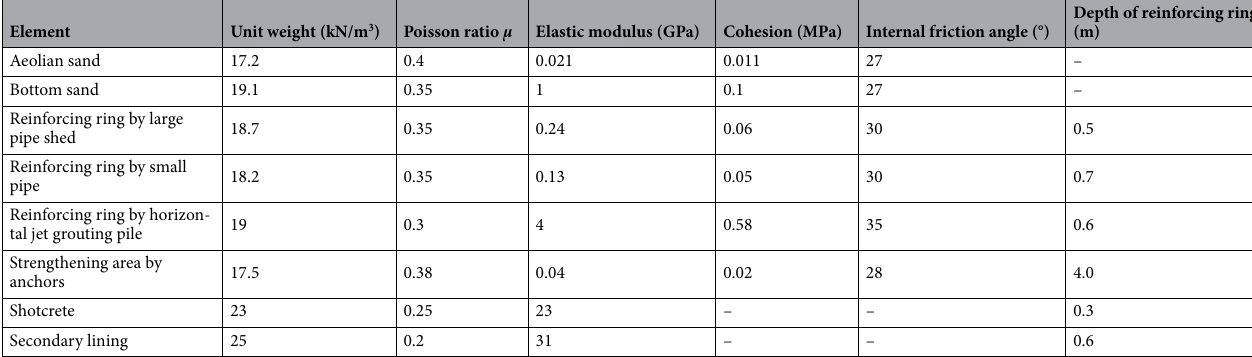
Table 7. Parameters for numerical simulation.